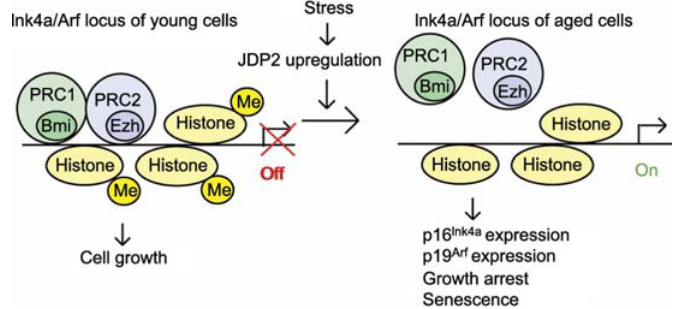
Figure 6 Model for epigenetic regulation of the p16 Ink4a /Arf locus by JDP2. Young primary cells exposed to oxidative stress accumulate JDP2. In the presence of JDP2, PRC1 and PRC2 dissociate from the p16 Ink4a